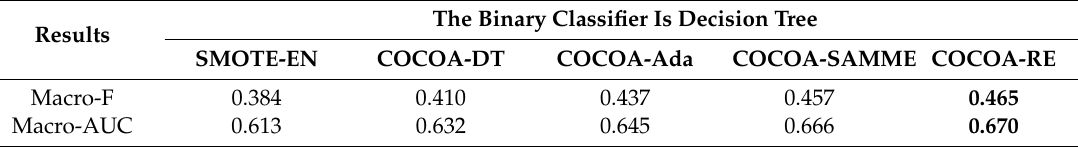
Table 4. The experimental results when the binary classifier is decision tree.